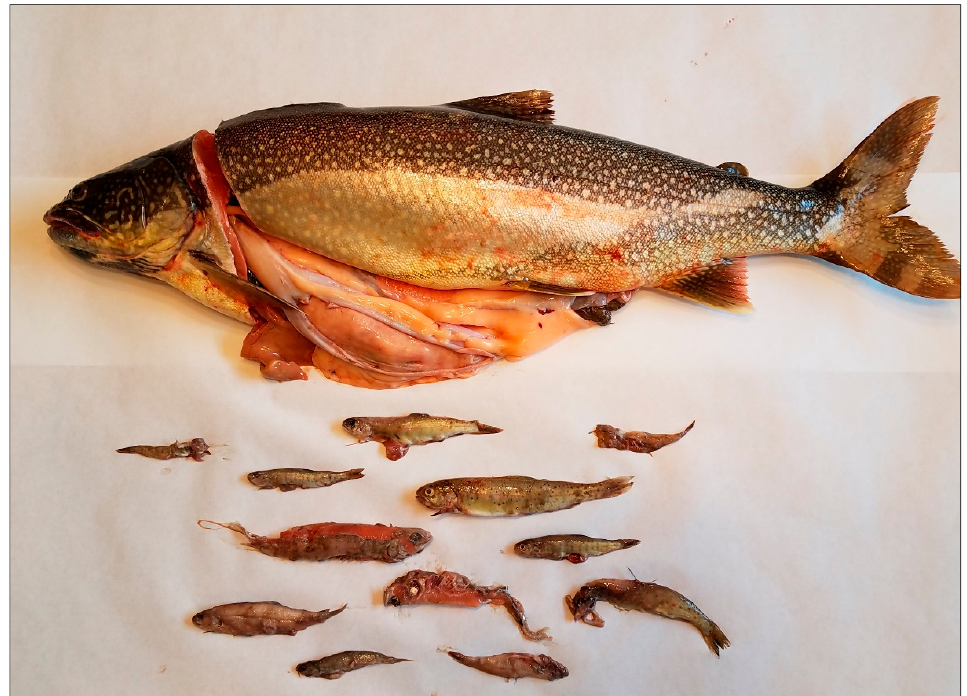
Figure 4. Twelve cutthroat trout from the stomach of a lake trout (approximately 3 kg) gillnetted